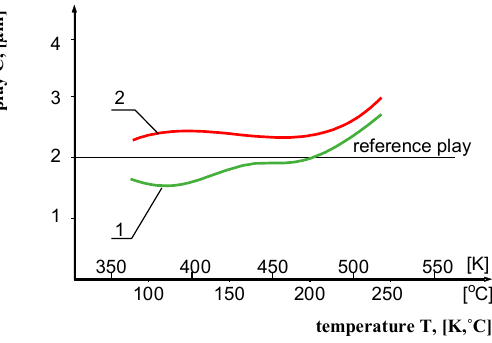
Figure 4. The play in the needle-nozzle holder precision pair of injector 8 as a function of operating temperature: 1—factory needle, 2—needle following additional thermal processing.